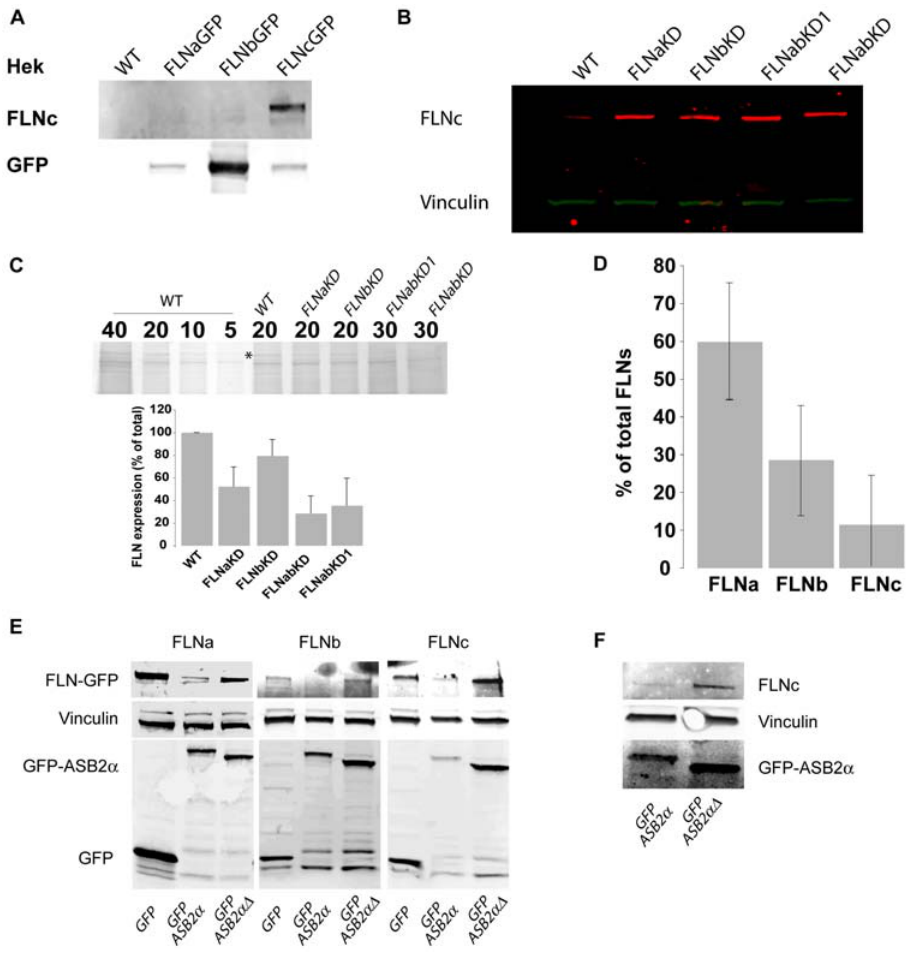
Figure 7. HT1080 express FLNc. A ) Cell lysates from HEK 293 cells or HEK cells expressing FLNa-GFP, FLNb-GFP or FLNc-GFP were probed by an anti-FLNc antibody (upper panel) or an anti-GFP antibody (lower panel). B ) 30 m g of lysates from the indicated cell lines were probed for FLNc content (red signal) and vinculin (green signal) used as loading control. C ) Cell lysates were fractionated by SDS-PAGE and gels stained for total protein. The extent of staining of a band of approximately 280 kDa (marked with an asterisk) that co-migrates with bands detected by anti-FLNa antibodies was measured. Bars show the results from 5 experiments (mean 6 SEM). D ) Estimation of total FLN levels in HT1080 WT. E ) HT1080 WT cells were co-transfected with FLNa-GFP (left panel), FLNb-GFP (middle panel), or FLNc-GFP (right panel) and GFP, GFP-ASB2 a or GFP-ASB2 aD as indicated. 24 hours after transfection cells were lysed, and analysed by western blotting for GFP. Vinculin staining was used as loading control. F ) HT1080 FLNaKD cells were transfected with either GFP-ASB2 a or GFP-ASB2 aD . 20 hours after transfection cells were lysed and analysed by western blotting for FLNc and GFP. Vinculin was used as loading control.